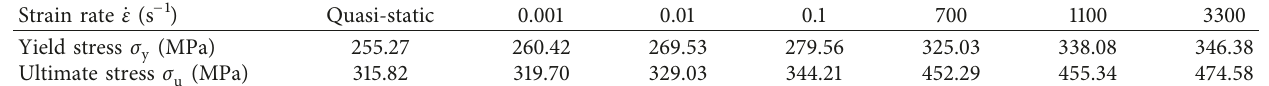
Table 4: The yield and ultimate stresses under different strain rates for 6005 Al alloy.